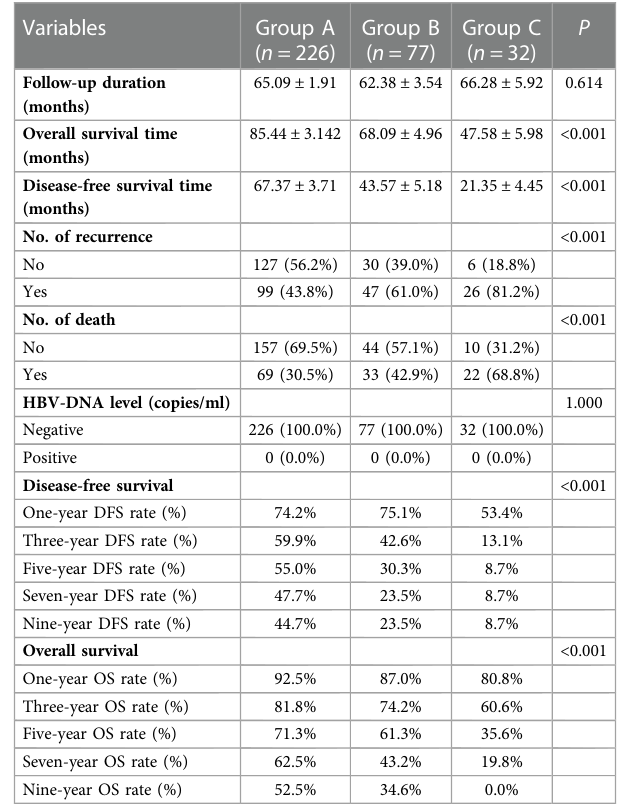
TABLE 3 Follow-up data. TABLE 2 Major complication classi fi cation and other clinical